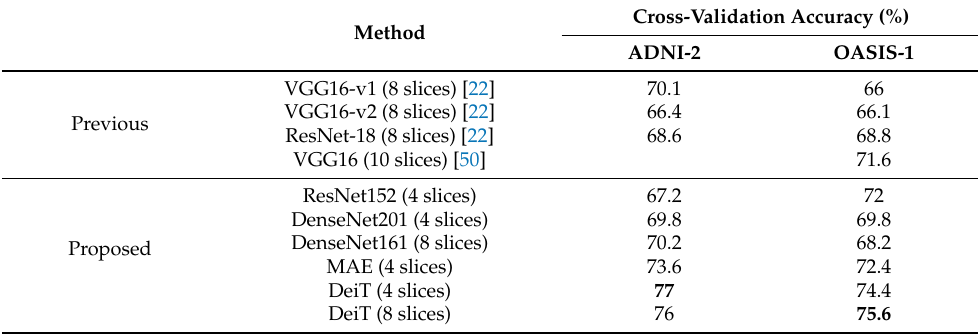
Table 4. Comparison of the proposed approach with leading ones (with no data leakage issue) in the literature. The bold style highlights the best classification results in each column.